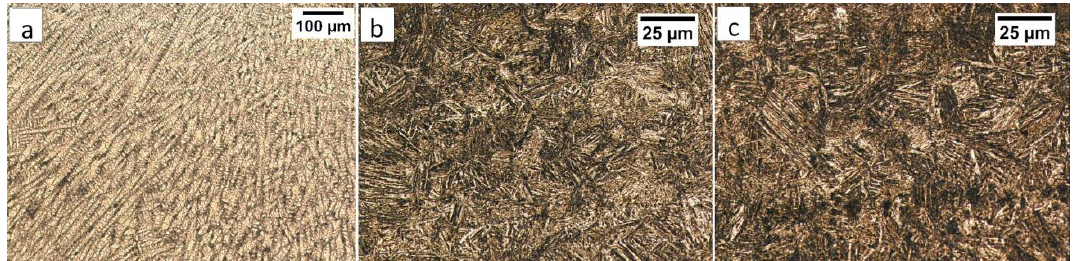
Figure 17. ( a ) The columnar, dendritic solidify structure in the area “A” (marked in Figure 16). Etched by saturated picric acid solution, LM. ( b ) The structure of the Fusion Zone in the area “A” (marked in Figure 16). Lath morphology of bainite. Etched by nital, LM. ( c ) The structure of the HAZ in the area “B” (marked in Figure 16). Lath morphology of bainite. Etched by nital, LM.